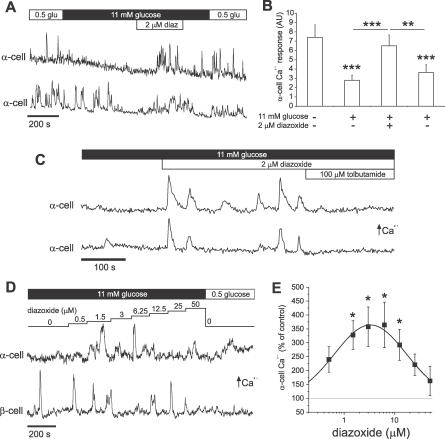
Intracellular Ca2+ Responses of α Cells within Intact Human Islets Are Regulated by a KATP Channel-Dependent Mechanism(A) Ca2+ responses measured in two human α cells within the same islet at 0.5 mM and 11 mM glucose (glu), in the presence of 2 μM diazoxide (diaz).(B) Summary of the Ca2+ responses at 0.5 mM glucose, at 11 mM glucose, in the presence of glucose (11 mM) and diazoxide (2 μM), and following the removal of diazoxide, but in the continued presence of 11 mM glucose.(C) The re-activation of human α-cell Ca2+ responses by 2 μM diazoxide was reversed upon application of the KATP channel antagonist tolbutamide (100 μM).(D) The effects of increasing concentrations of diazoxide on the Ca2+ response of a human α cell and β cell within the same islet exposed to 11 mM glucose. At the end of the experiment, diazoxide was withdrawn and glucose lowered to 0.5 mM.(E) Dose-response curve for the effect of diazoxide on α-cell Ca2+ responses. The grey horizontal line indicates the response with 11 mM glucose alone.*, p < 0.05; **, p < 0.01; ***, p < 0.001, compared with controls, unless otherwise indicated.